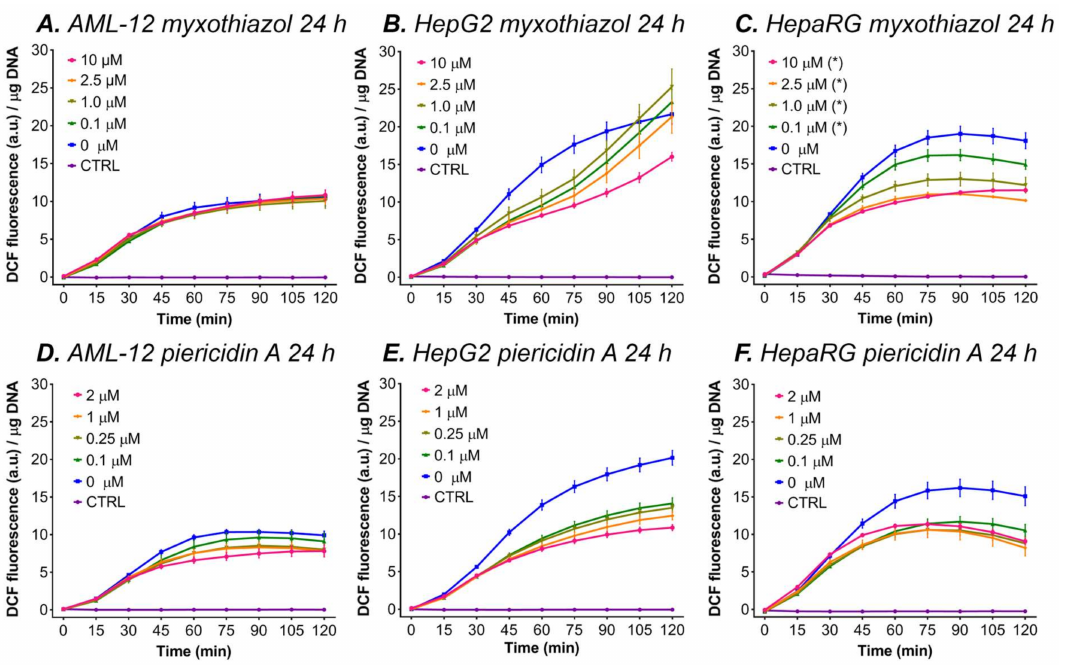
Figure 5. DCF fluorescence per µ g DNA during a 2-h kinetic read after myxothiazol incubation for 24 h in AML-12, HepaRG, and HepG2 cells. The data are presented as mean ± SEM (n = 4/group) to increase graph legibility. (*) = ∆ flu (flu at t = 120 − t = 0) is significantly different vs. 0 µ M ( p < 0.05 one-way ANOVA, Dunnett’s post hoc test). The control (CTRL) cells were not incubated with DCFH 2 -DA. Abbreviations: DCF = 2 (cid:48) ,7 (cid:48) -dichlorofluorescein; a.u. = arbitrary units.